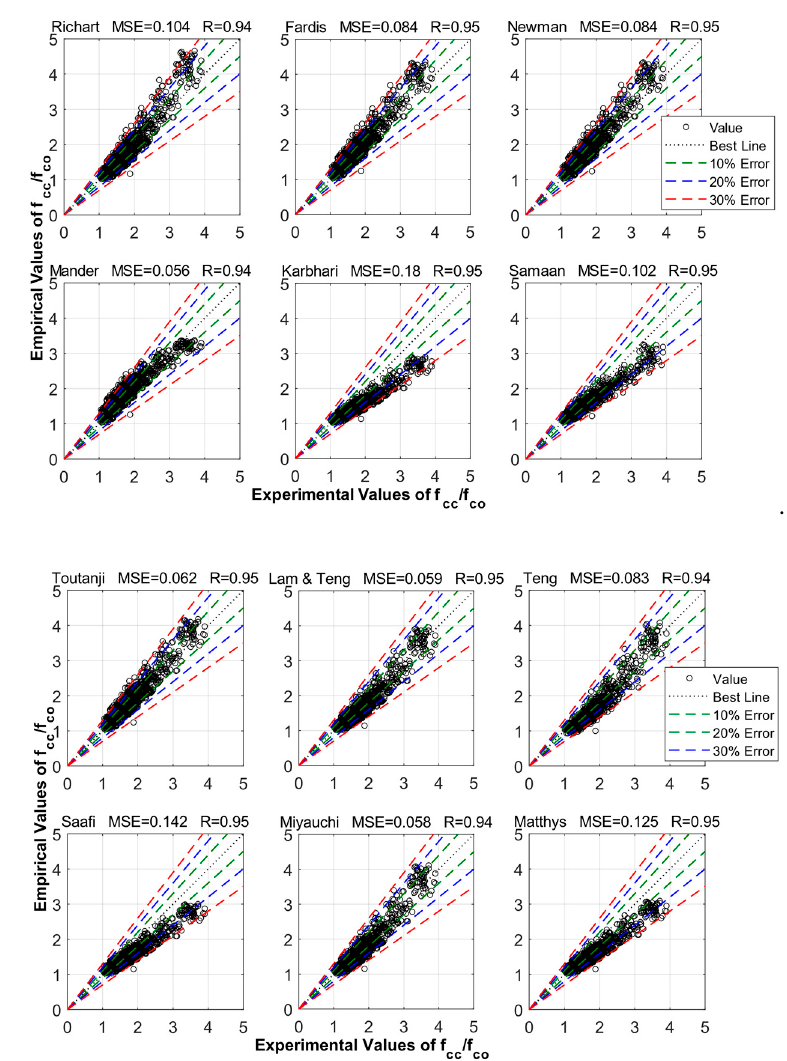
Figure 7. Performance of previously proposed strength models of confined concrete on the developed database.